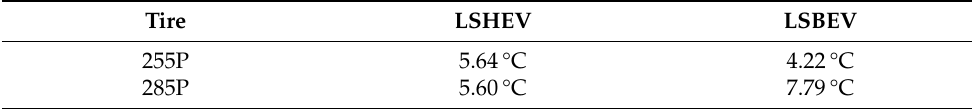
Figure 7. Impact of mixed mounted tires on rolling coefficients used in (1). Looking at the relationship of identical tires mounted on different cars, a clear trend is visible. The relation between tire 255P and tire 285P mounted on different cars, as indicated by the slope of the connecting lines, does not change as much as the absolute values of each tire on different vehicles. This shows a dependency of the rolling noise of the used vehicle, and leads to the assumption that the vehicle design criteria has a fixed impact on every mountable tire. In numbers, the SPL of the LSBEV driving 50 km h − 1 is 0.82 dB ( A ) and 0.57 dB ( A ) louder than on the LSHEV for the tires 255P and 285P. The average temperatures of the measurements are shown in Table 1. Taking into account that the temperature correction may have an error as well, it is reasonable to assume that the correction leads to a slight underestimation of the 285P mounted on the LSBEV, which would lead to a near constant error between LSHEV and LSBEV of 0.8 dB ( A ) . That hypothesis is being supported by the figure as well, since it shows that the temperature correction almost solely affects the a coefficient (as can be seen by the pure shift to the left in the figure). Table 1. Air temperature of Pirelli PZero rolling measurements.